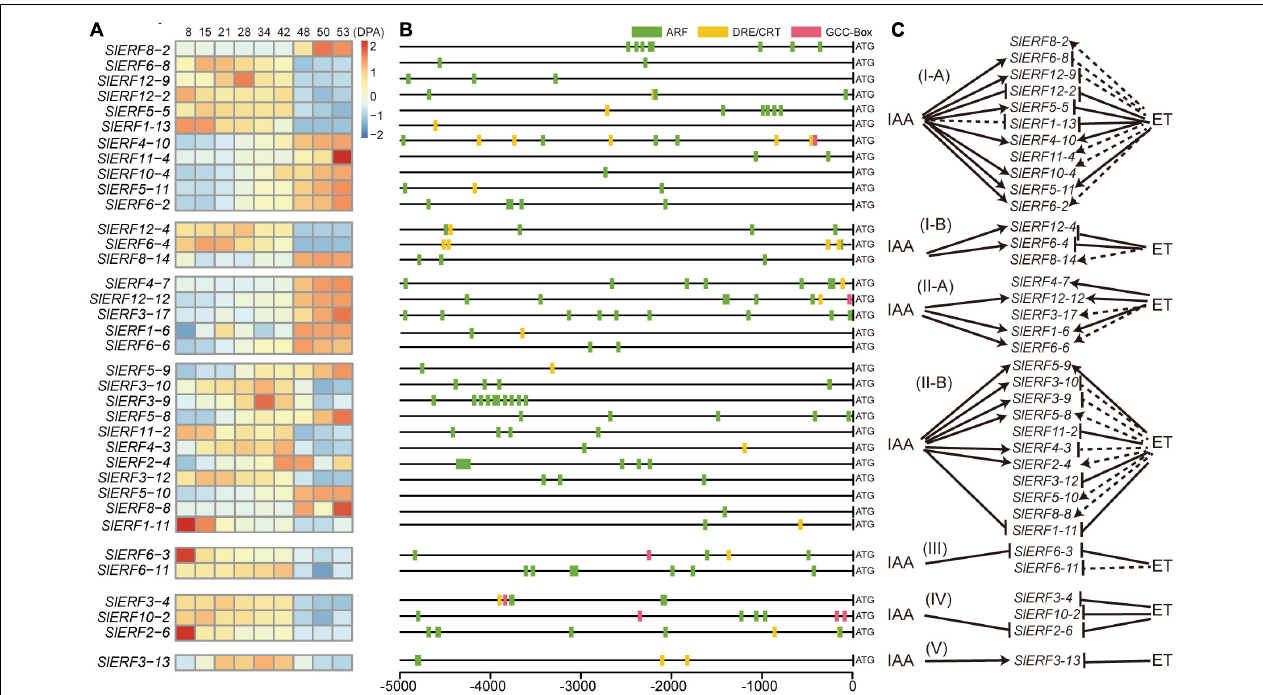
FIGURE 4 | The relationship of DREB and ERF subfamily genes with tomato fruit development and ripening. (A) Heatmap analysis of 36 SlERF genes based on TPM values from 8 to 53 DPA. (B) ARF, DRE/CRT, and GCC boxes analysis of 36 SlERF gene promoters. (C) Relationship of 36 SlERF genes with IAA and ET signals. Black solid arrow, indicates direct positive regulation; black dashed arrow, indicates indirect positive regulation; black solid lines ending with bar, indicates direct repression; black dashed lines ending with bar, indicates indirect